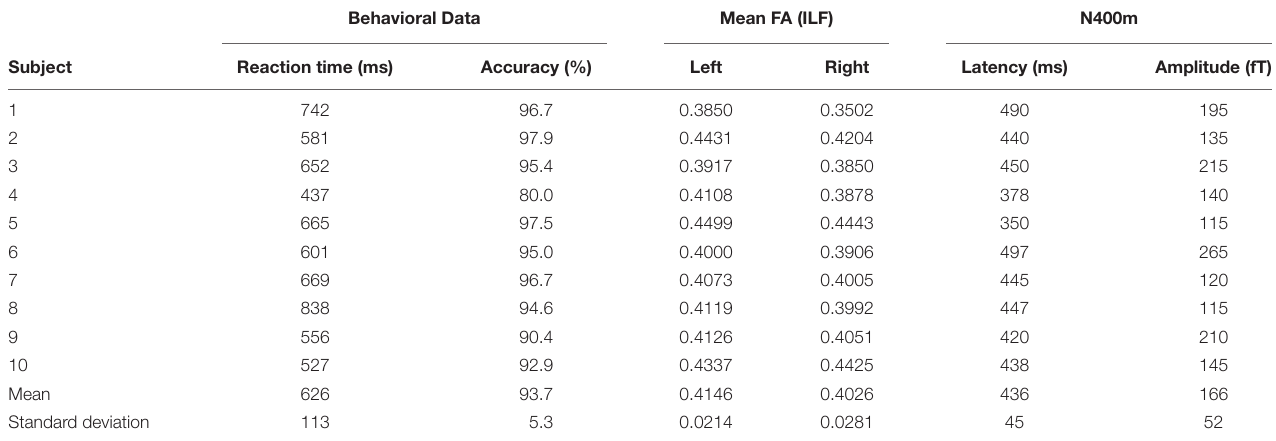
TABLE 1 | Summary of behavioral